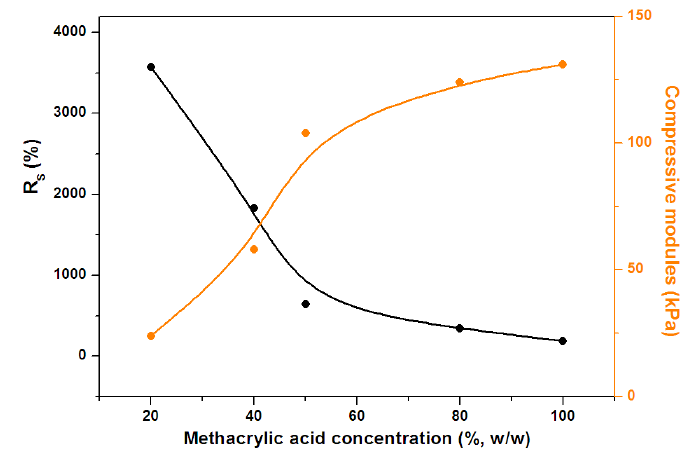
Figure 5. Effect of methacrylic acid concentration on hydrogel swelling ability and compressive modules.